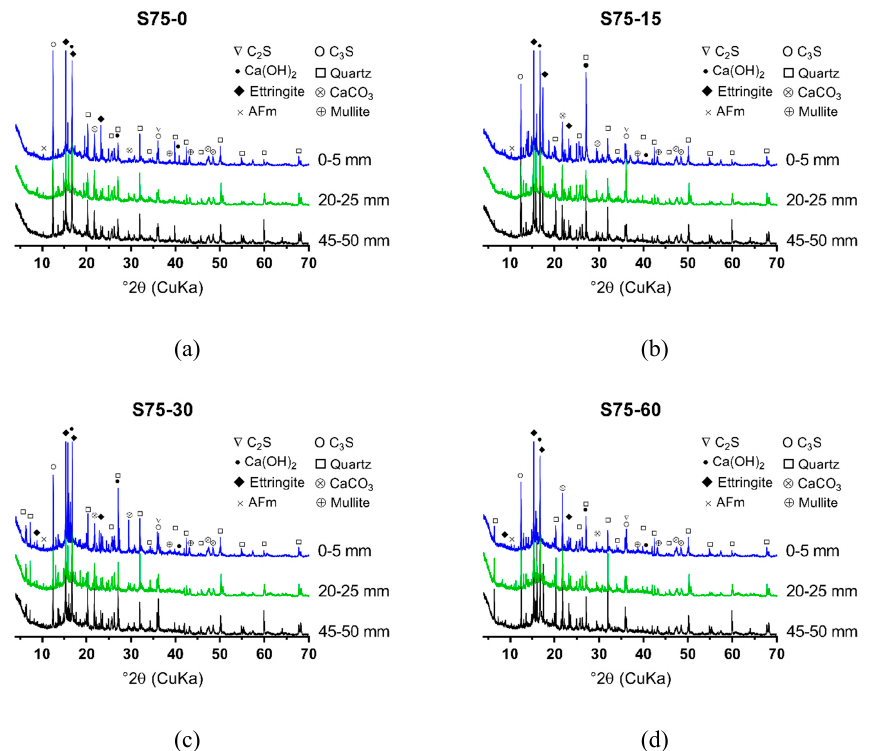
Figure 8. XRD spectrum of the powder samples from S75, after 0, 15, 30, and 60 cycles of sulfate attack (sample location distance to the attack surface: 0–5 mm, 20–25 mm, and 45–50 mm): ( a ) S75-0; ( b ) S75-15; ( c ) S75-30; ( d ) S75-60.